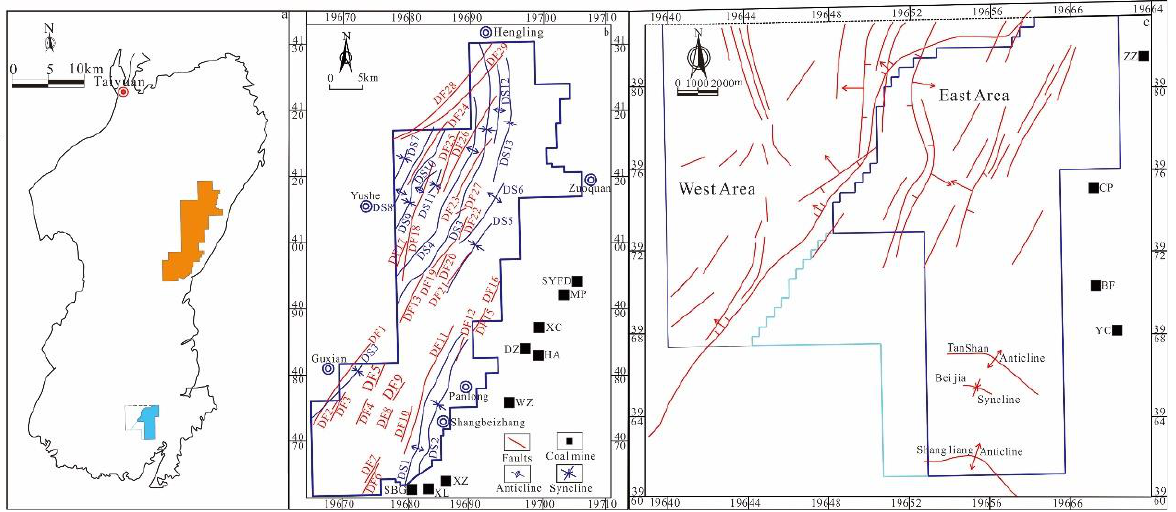
Figure 1. Location of the middle-high rank coals(a.Qinshui Basin b.Yushe-wuxiang Block c.Shizhuangnan Block) (Cited from Zhang et al.).